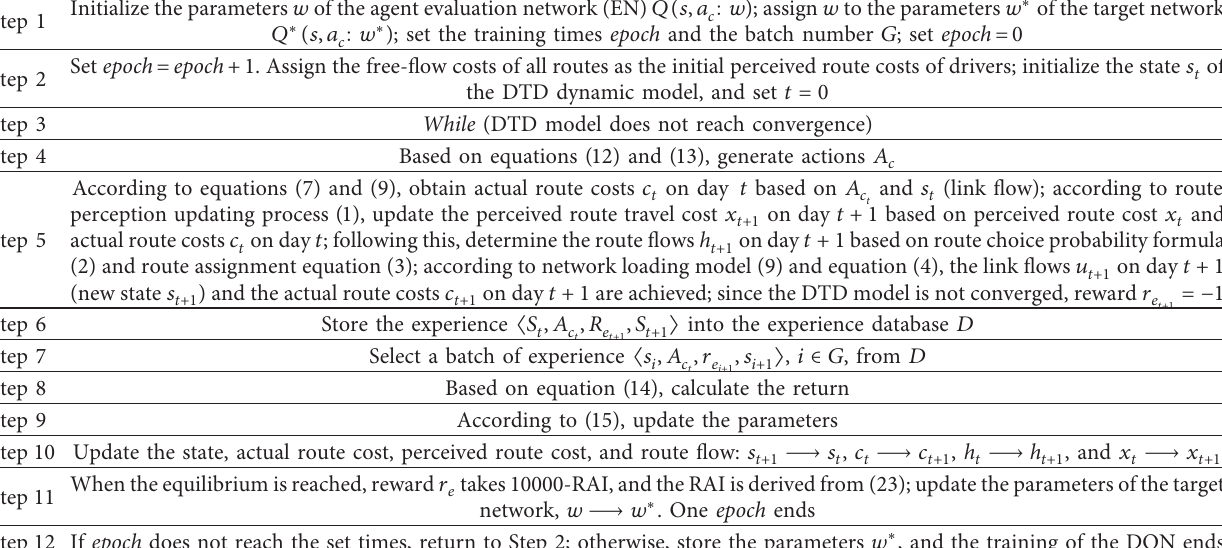
Table 1: The training of the DQN.